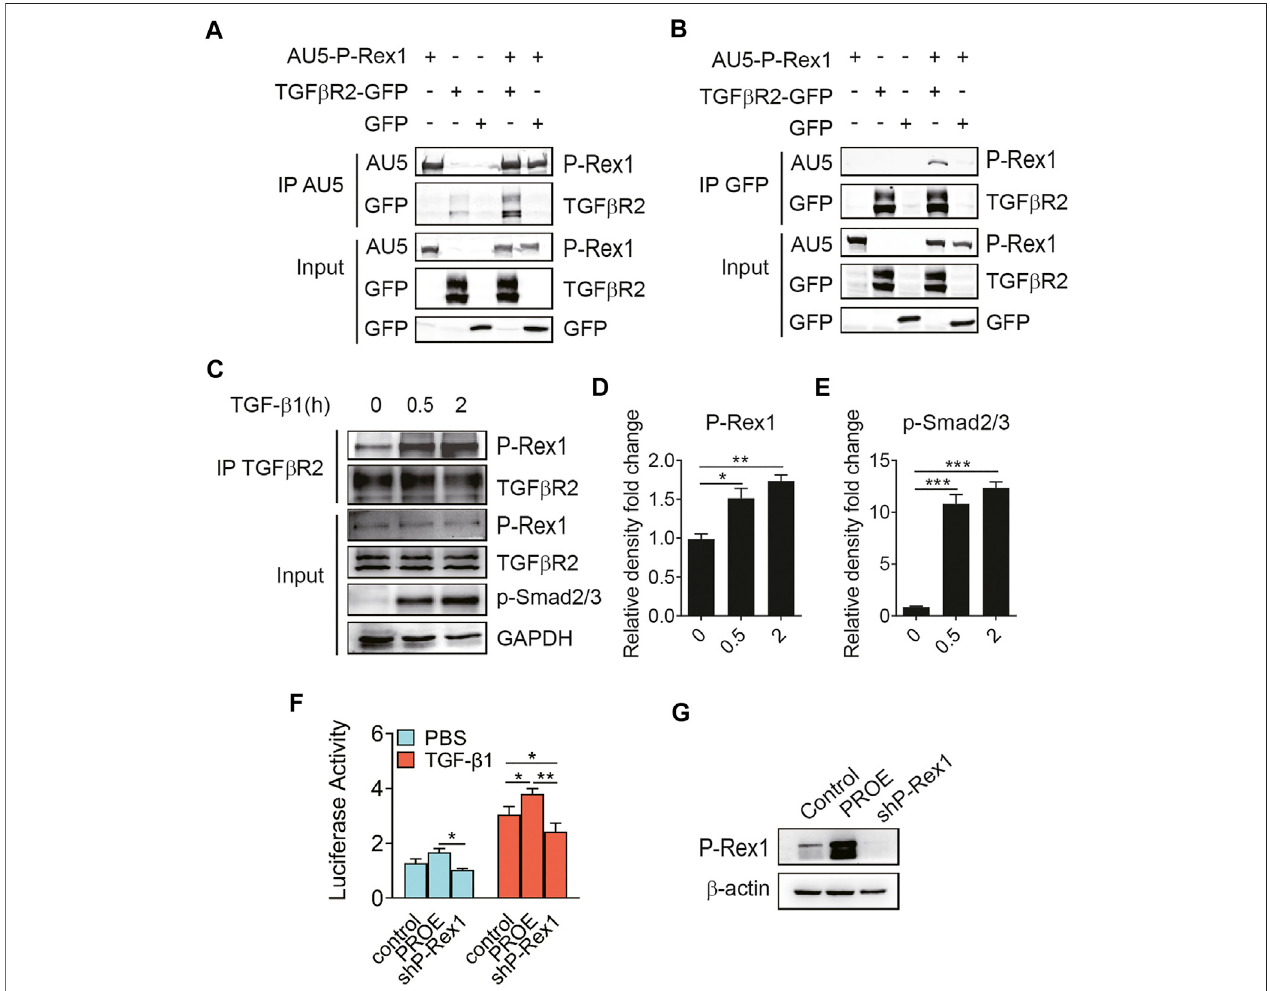
FIGURE4| AssociationofP-Rex1withTGF β R2inlung fi broblast. (A , B) 293TcellsweretransfectedwithAU5-taggedhumanP-Rex1,GFP-taggedTGF β R2,and GFP. Cell lysates were collected and subjected to immunoprecipitation using anti-AU5 antibody or anti-GFP antibody. Beads and total cell lysates were resuspended in loading buffer for analysis by Western blot. (C) Mouse lung fi broblasts were subjected to immunoprecipitation using an anti-TGF β R2 antibody post TGF- β 1 (10 ng/ml) challenge. P-Rex1 expression was determined. (D , E) Quanti fi cation of data in C . (F) Luciferase activity of fi broblasts with P-Rex1 or shP-Rex1 transfection using SBE4-Luc reporter gene. (G) Expression of the P-Rex1 in fi broblasts. The data are shown above as mean ± SEM from three independent experiments. (* p < 0.05, ** p < 0.01, and *** p < 0.001).